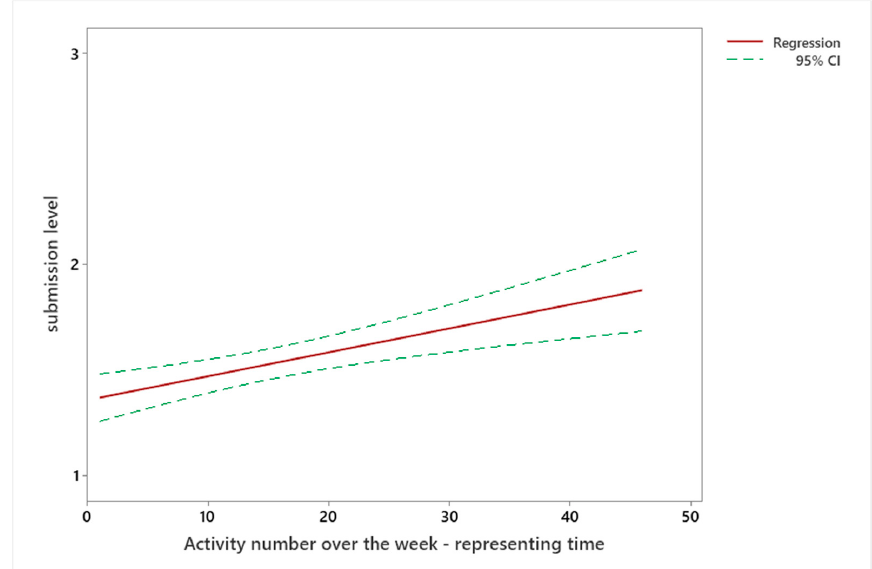
Figure 3. Submission levels (1–3; 1 = low and 3 = high level) of work submitted in relationship with activity number in the order of delivery.